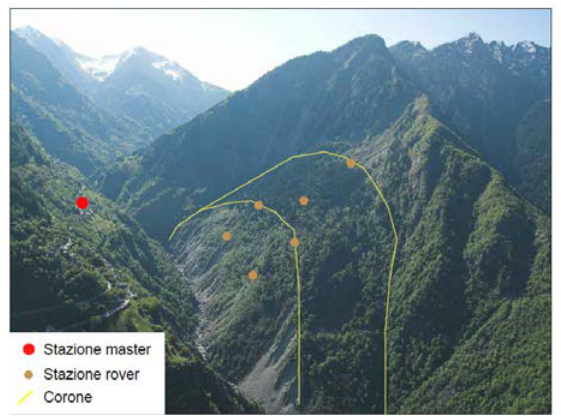
Figure 5. Locations of the GNSS rover antennas in correspondence of CPs (brown dots) on the landslide body and the reference master station (red point) on the opposite flank of the Tartano Valley. The upper limit of two existing niches of the landslide body are overlaid (yellow lines).